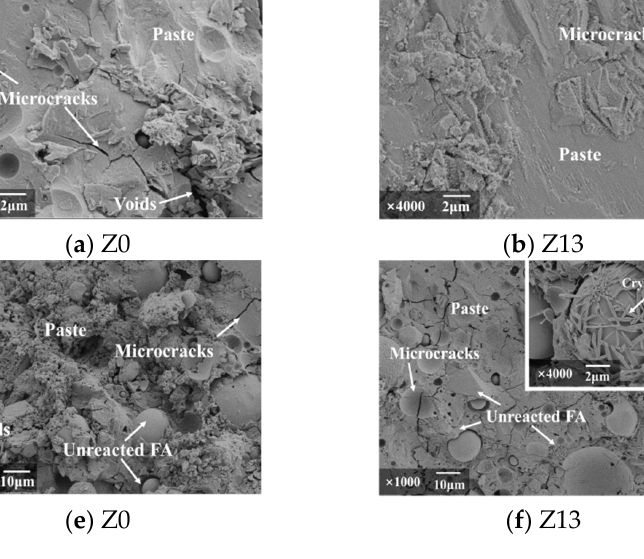
Figure 9. Microstructures of geopolymers with different mixing ratios.